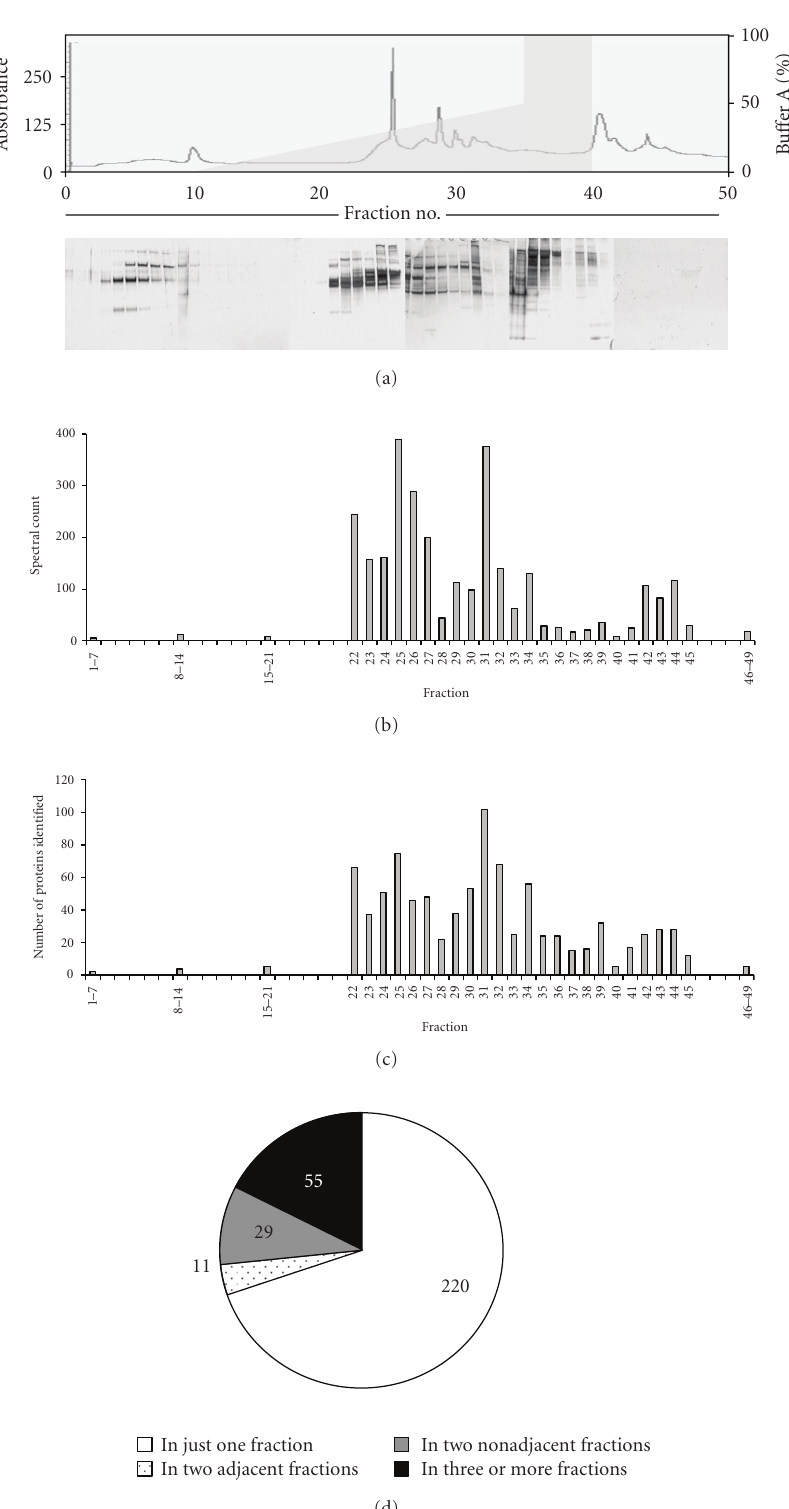
Figure 3: Fractionation of the platelet releasate by ion-exchange chromatography. (a) From each releasate fraction collected, 80 μ L was precipitated to remove salt, resuspended in 10 μ L of Laemmli bu ff er, and separated by MW on 4%–20% acrylamide gels. Silver-stained gels are displayed below corresponding sections of the ion-exchange UV detected chromatogram. A UV wavelength of 280nm was used to detect eluting peptides. (b) The number of spectra detected in each fraction following LC MS/MS of tryptically digested 1D gel pieces. (c) The number of proteins identified in each fraction using SEQUEST with a score greater than 0.9. (d) Representation of the number and proportion of proteins in a single fraction, two adjacent fractions; two nonadjacent fractions, or more than two